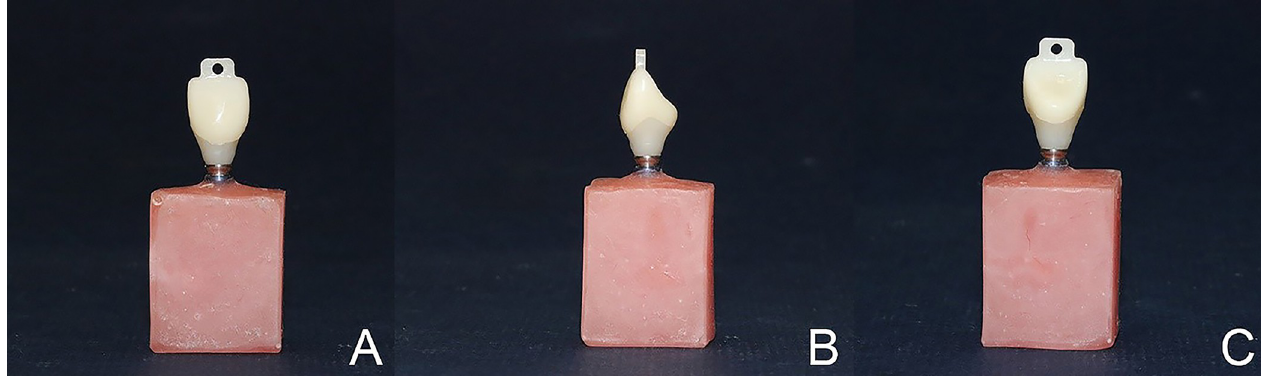
Fig 2. A full contour right maxillary central incisor crown with a projection on its incisal edge. A: buccal surface, B: proximal surface, C: lingual surface. Forty-two ceramic crowns (n = 21 per group) were fabricated with either ultrahigh-translucent monolithic zirconia in A2 shade (ZIRAE; SHT